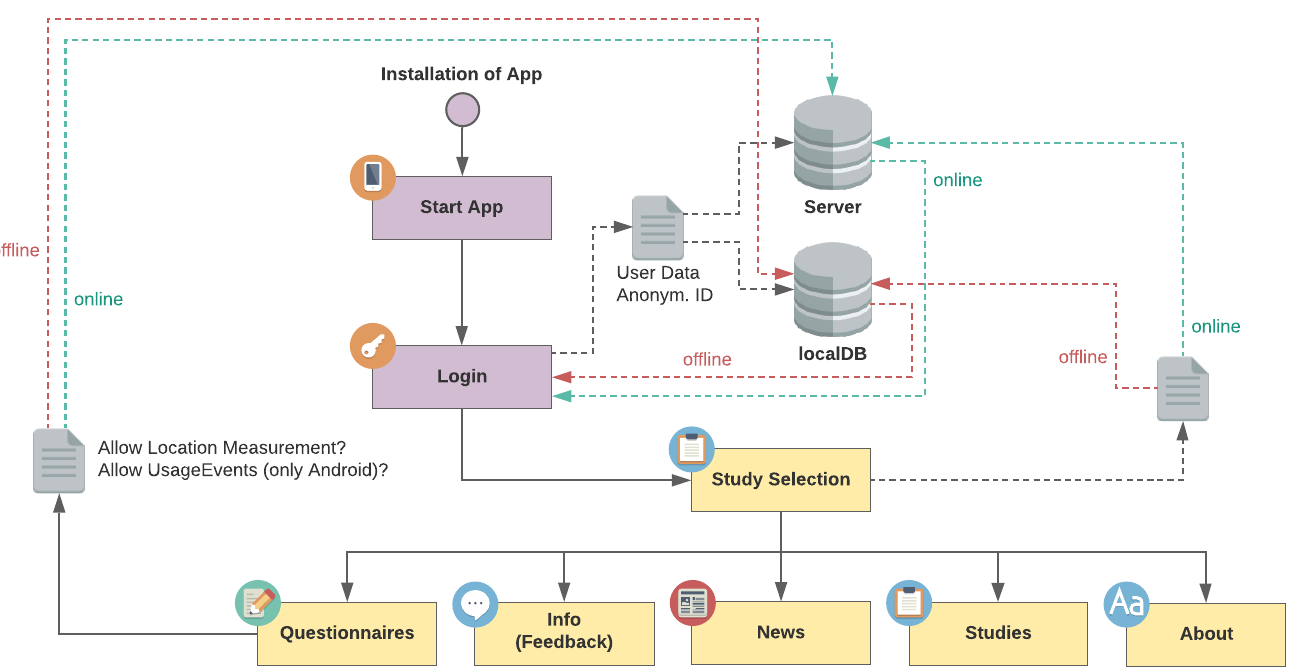
Figure 4. Corona Health processes of the User Journey on a technical level. Continuous lines indicate user interactions and dashed lines indicate background data interactions. After installation, the app can be started and an anonymous login process is started. If the backend server cannot be reached, the local database temporarily handles the login, storage of questionnaires and mobile sensing data.